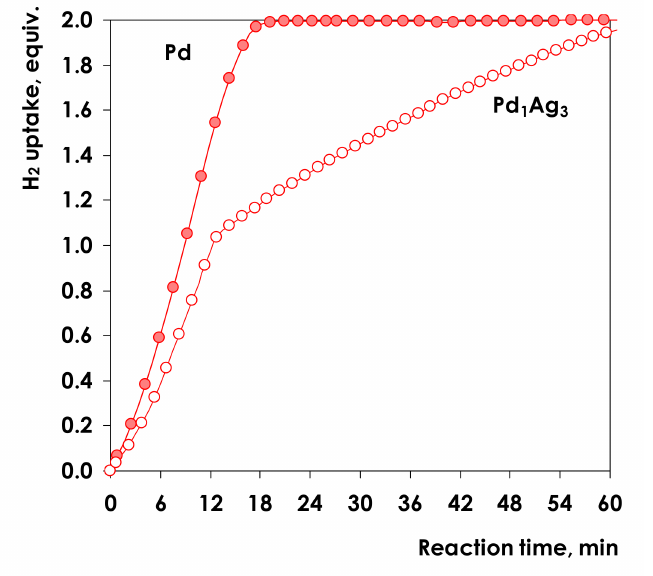
Figure 5. Hydrogen uptake vs. reaction time in the liquid-phase hydrogenation of 1-Ph-1-Pr over Pd and Pd 1 Ag 3 . Conditions: T = 25 ◦ C, P(H 2 ) = 5 bar, m(Pd) = 1.5 mg, m(Pd 1 Ag 3 ) = 7.5 mg, V C6H14 = 6